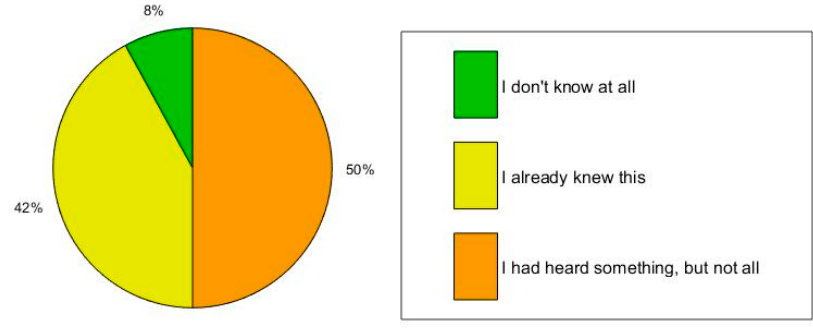
Figure 2. Awareness about drinking water standards and water treatment.